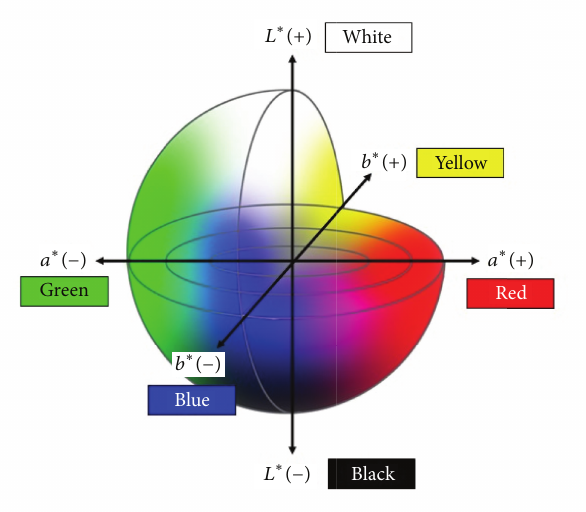
Figure 3: In the 𝐿 ∗ 𝑎 ∗ 𝑏 ∗ color space system the color differences are visualized as distances in a diagram. 𝐿 ∗ : color brightness ( 𝐿 ∗ = 0 is black and 𝐿 ∗ = 100 is white). 𝑎 ∗ : position between red and green (negative values are progreen; positive values are prored). 𝑏 ∗ : position between yellow and blue (negative values are problue; positive values are